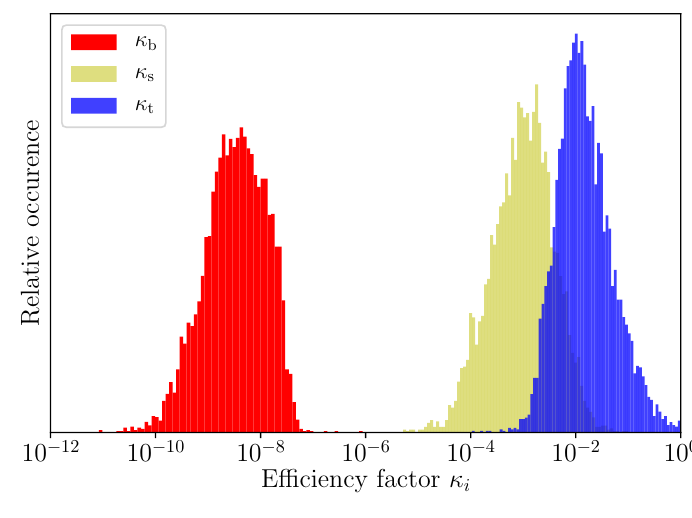
Figure 1. Distribution of e(cid:14)ciencies in the xSM for converting the energy released during the SFOPT into collisional energy of the bubbles (b, red), sound waves (s, yellow), and turbulence (t, blue). The normalization of the vertical axis is arbitrary. Note that, here and in the rest of our analysis, we have (cid:12)xed the bubble wall velocity at v w = 0 : 9 in order to increase the strength of the GW signal. As a consequence, most of the parameter points in our scan describe phase transitions of the detonation type. For lower velocities, which typically result in sub- or supersonic de(cid:13)agrations and which are relevant in the context of electroweak baryogenesis [42], the GW signal from sound waves can be signi(cid:12)cantly suppressed